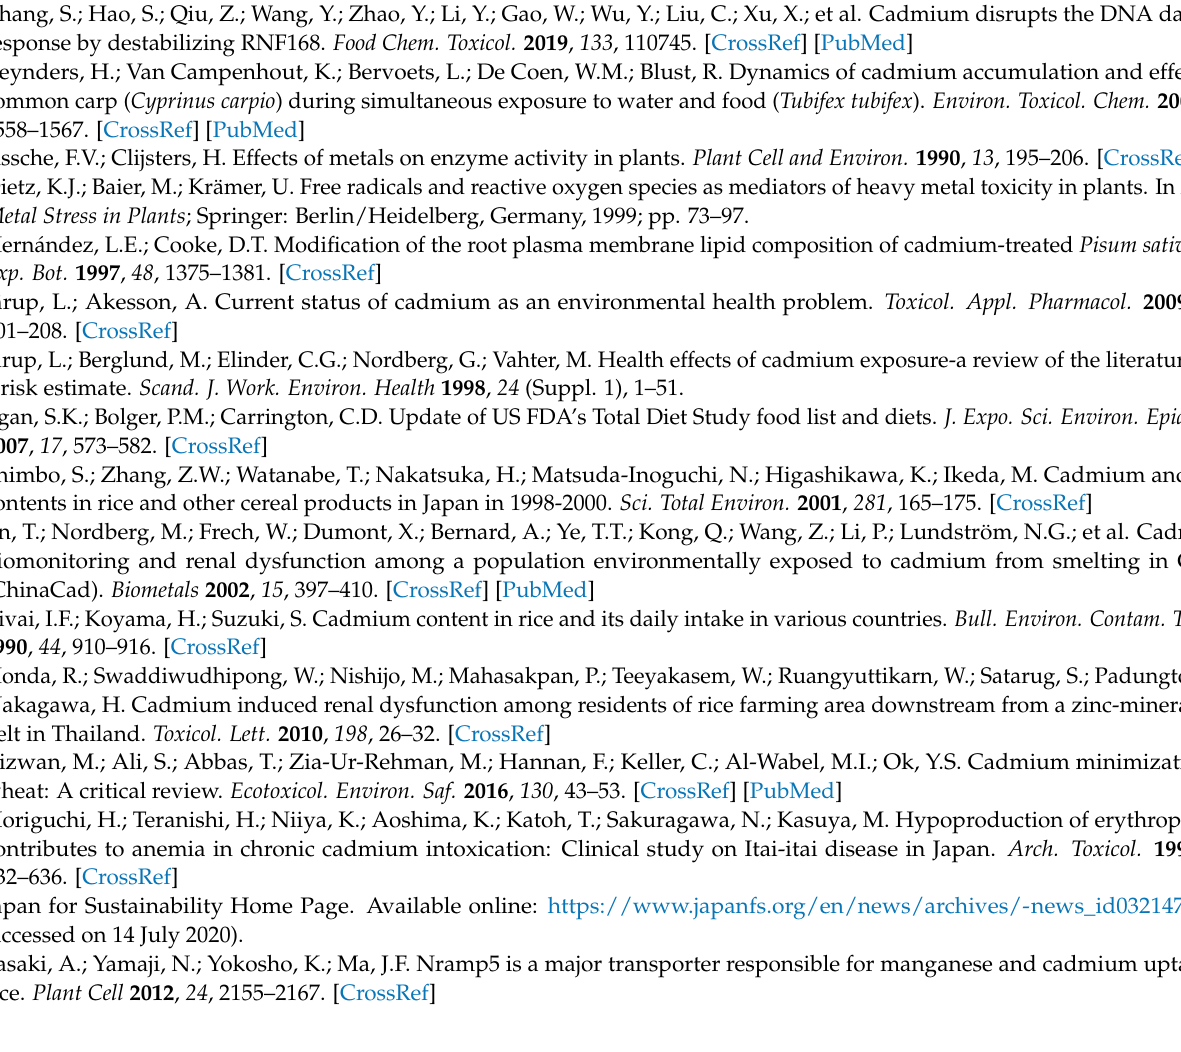
Figure S5: Expression of OsNRAMP5 , OsHMA3 , OsLCT1 and OsO3L2 in OsABCG48 overexpression line C6.2. Table S1: Primers sequences. Tables S2–S5: DEGs from WT − Cd vs. WT + Cd, 2B − Cd vs. 2B + Cd, 2B − Cd vs. WT − Cd and 2B + Cd vs. WT + Cd, respectively. Table S6: Transformation